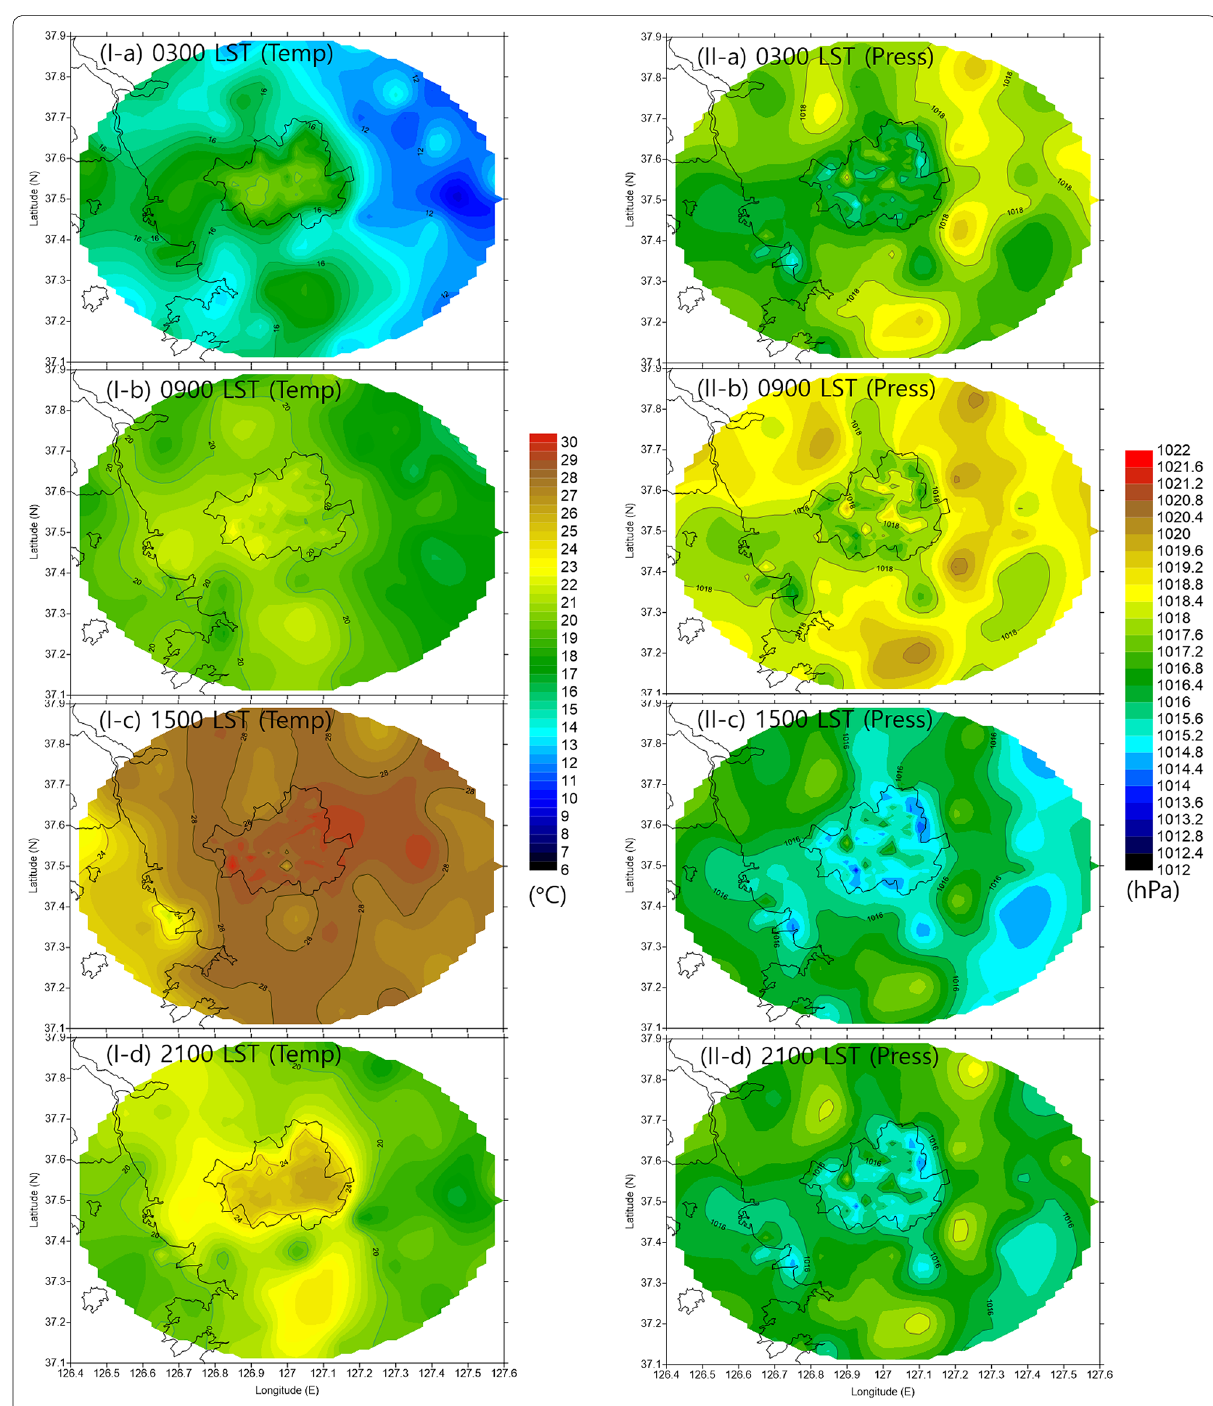
Fig. 3 Horizontal distribution of the air temperature (left) and sea‑level pressure (right) at a 0300 LST, b 0900 LST, c 1500 LST, and d 2100 LST averaged over 6 days from 17 to 22 May